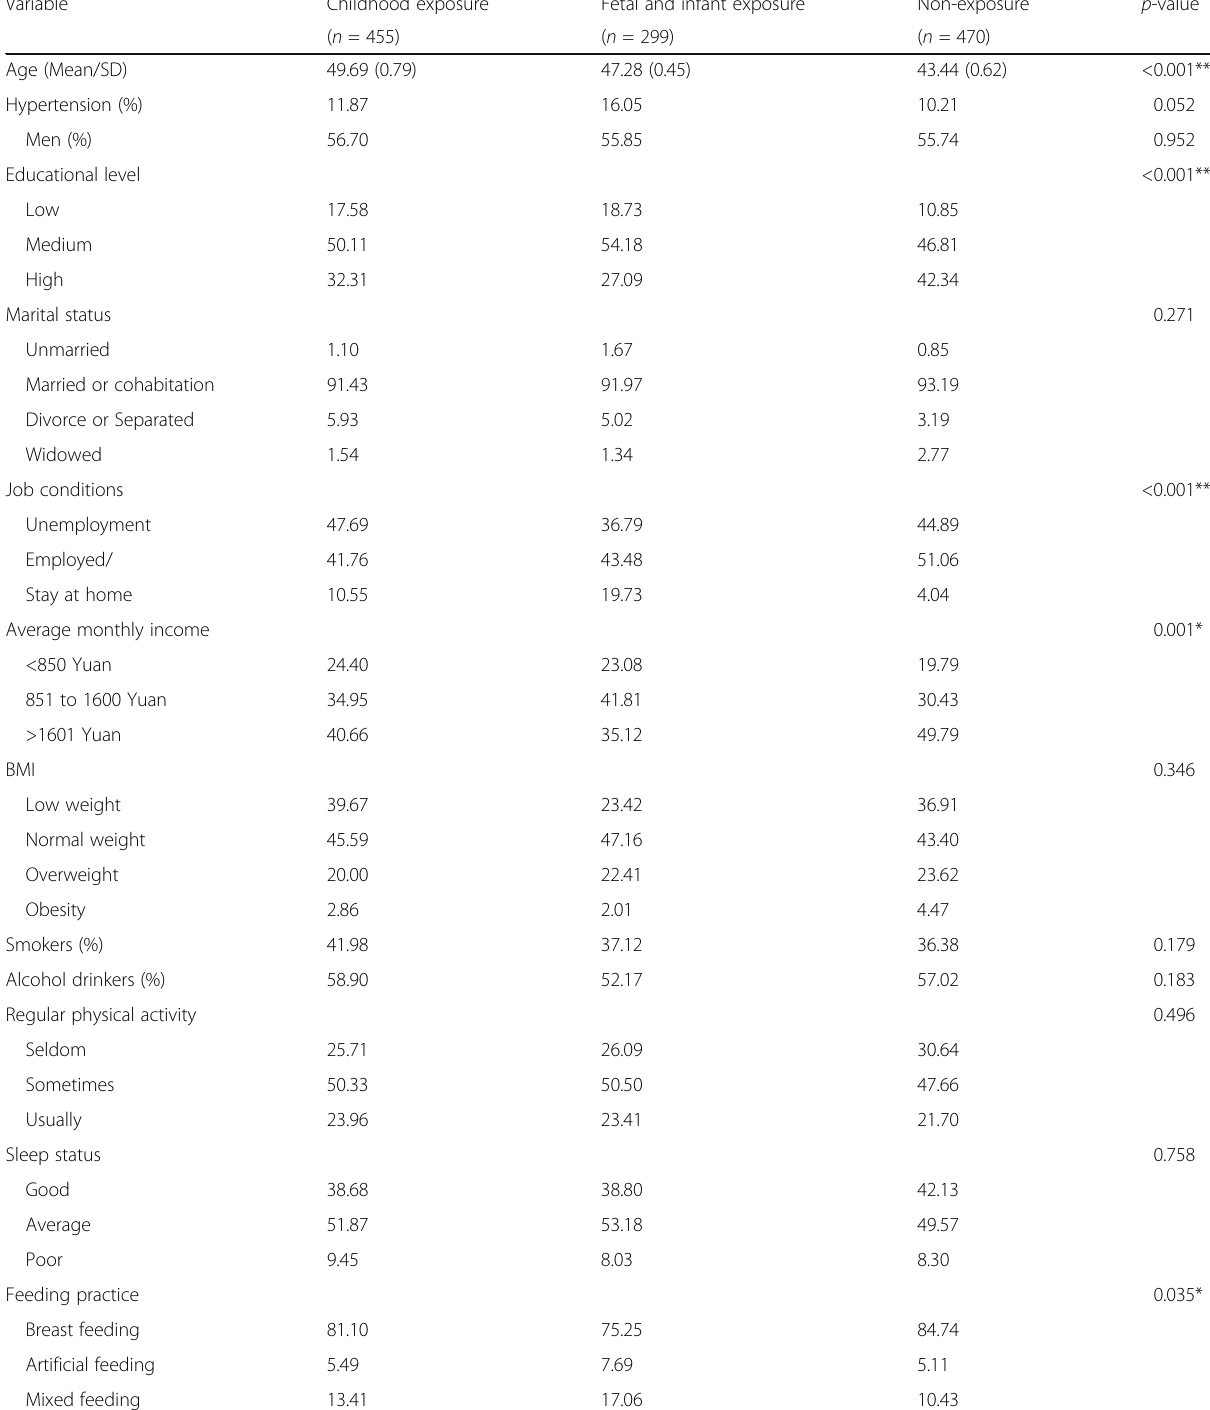
Table 2 Characteristics of the study participants, Chongqing, China Variable Childhood exposure Fetal and infant exposure